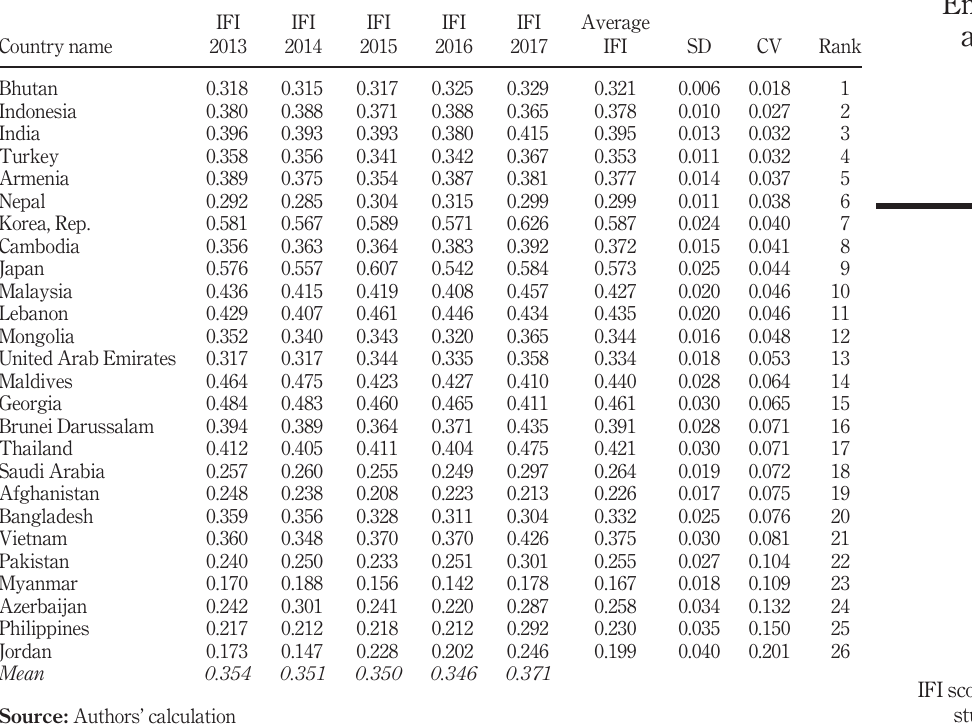
Table 8. IFI scores for the study